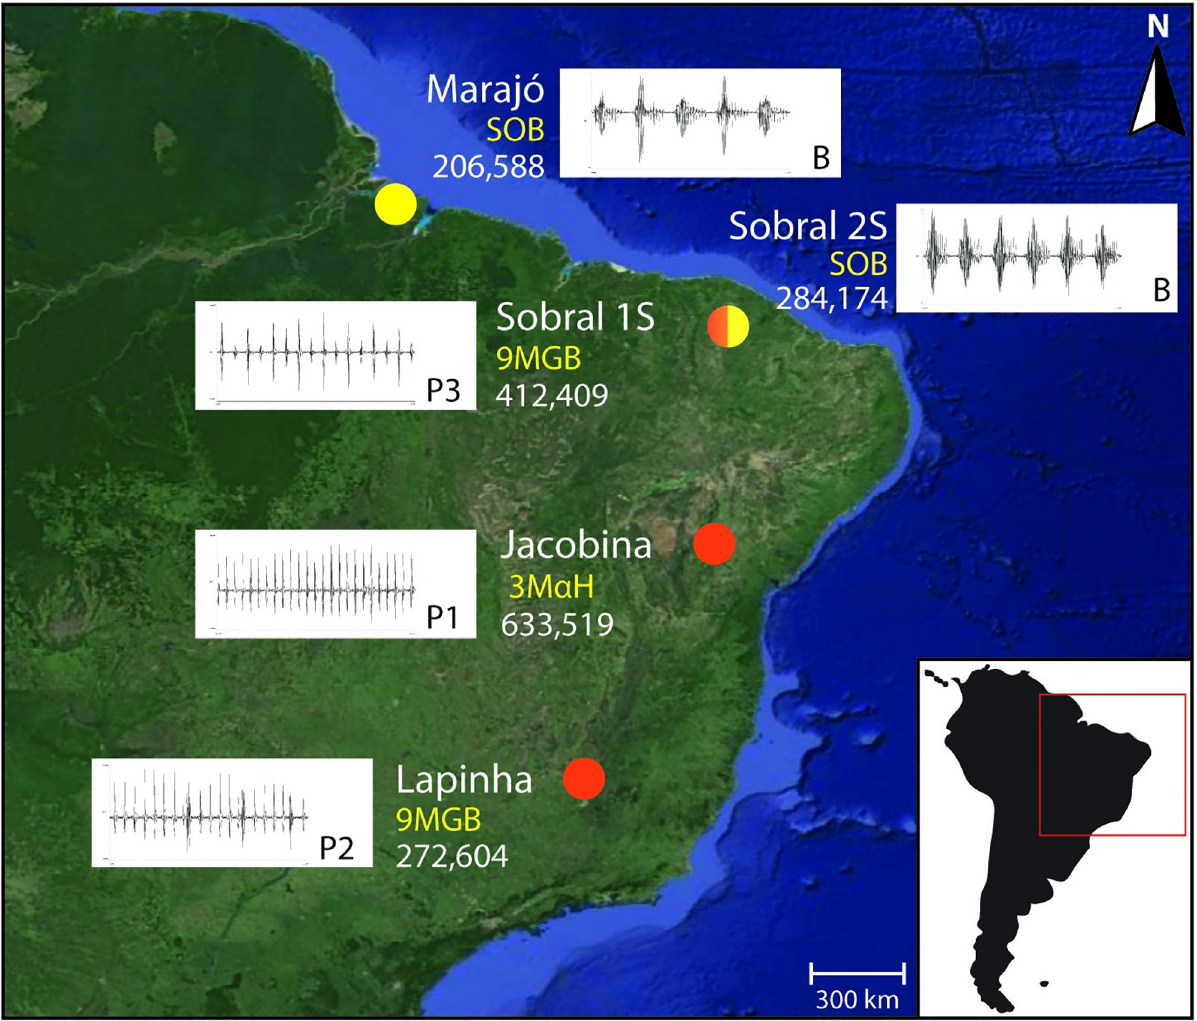
Fig 1. Lutzomyia longipalpis site locations for copulation songs and pheromone types. Samples were collected from three allopatric populations: Marajo´ (Para´ State; 0˚56’S 49˚38’W), Jacobina (Bahia State; 11 0 10’S 40 0 31’W), and Lapinha Cave (Minas Gerais State; 19 0 33’S 43 0 57’W); and two sympatric populations from Sobral (Ceara´ State; 3 0 41’S 40 0 21’W). Copulation songs: Burst-type (B) and Pulse-types (P1, P2, and P3). Pheromone types: sobralene (SOB), ( S )-9-methylgermacrene-B (9MGB), and 3-methyl- α -himachalene (3M α H). For each location, the number of SNPs identified in each population with respect to the reference genome (VectorBase, LlonJ1) is indicated. A total of 1,937,819 SNPs were identified among all the populations. Main map source: World Imagery (Source: Esri, Maxar, Earthstar Geographics, and the GIS User Community; http://goto.arcgisonline. com/maps/World_Imagery). Inset map source: World Dark Gray Canvas Base (Esri, HERE, Garmin, OpenStreetMap contributors, and the GIS user community;